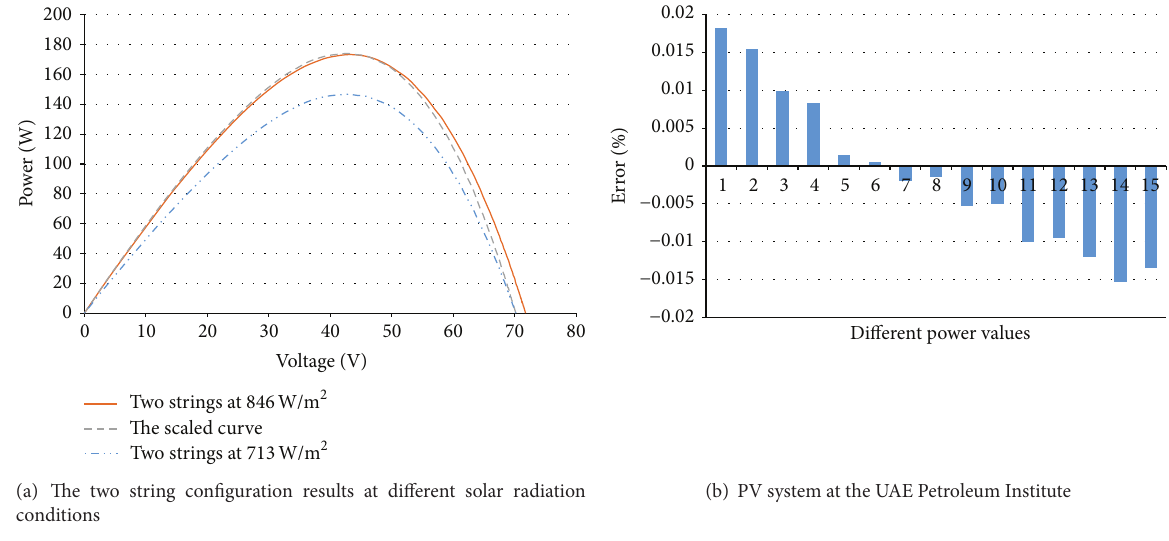
Figure 7: Error analysis of results.